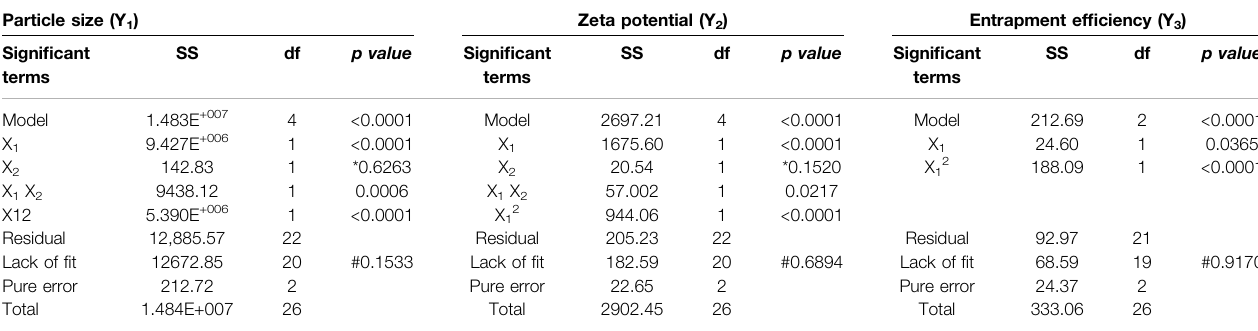
TABLE 1 | Statistical output (ANOVA) for optimization model for all responses. Particle size (Y 1 ) Zeta potential (Y 2 )